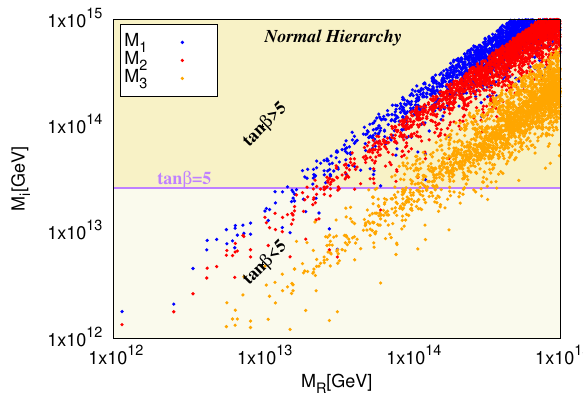
Figure 4 . The RH neutrino masses ( M 1 , M 2 and M 3 ) as a function of the Majorana mass scale M R